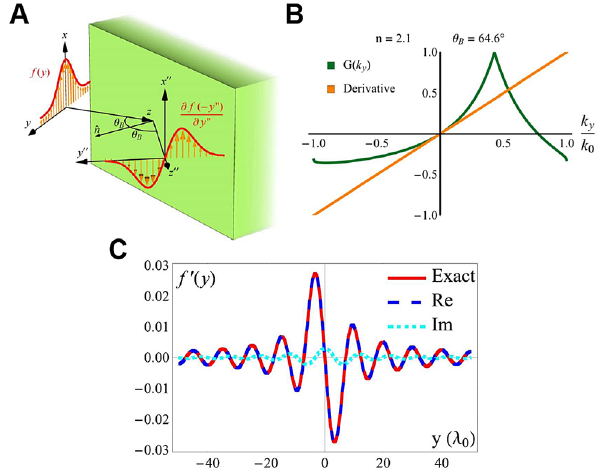
Figure 15: Example of nonresonance-based GF approach. (A) The realization of the first-order differentiation when an incident beam impinging and reflected at Brewster angle [64]. (B) The exact and approximated GF distribution corresponding to the fi rst-order differentiation. (C) Comparison of the exact solution and the simulated fi rst-order derivation for an input Sinc function with W = 0.09 k 0